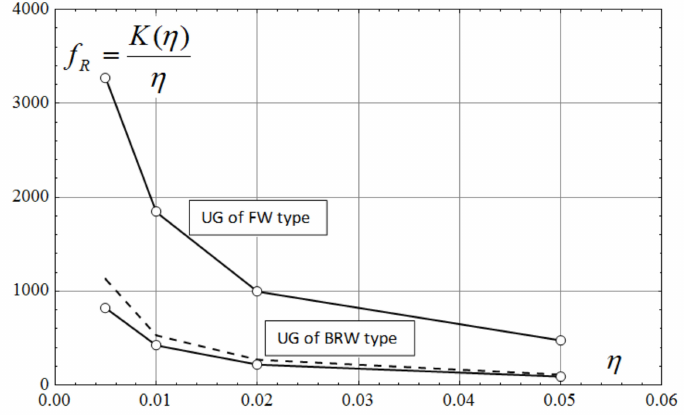
Figure 8. Range function for UG of the BRW and FW types versus the relative differential buoyancy for equal volume of pressure hull ( V 0 = 0.042 m 3 ).